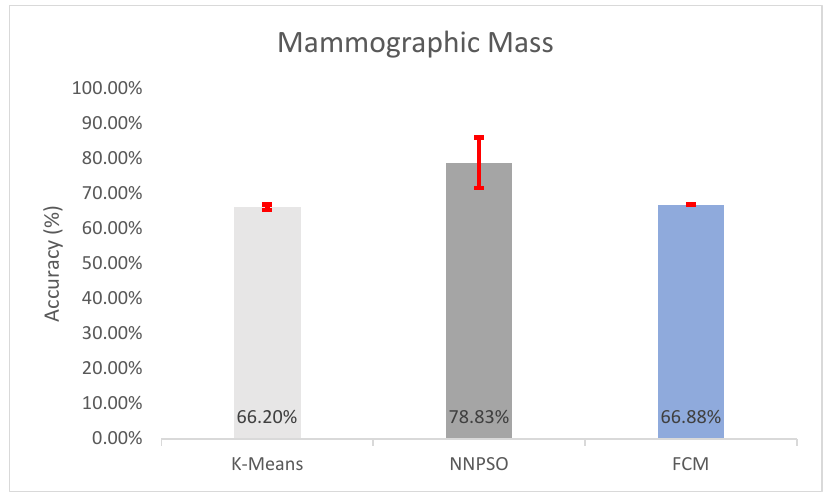
Figure 22. Accuracy of the algorithms on the Seeds dataset.